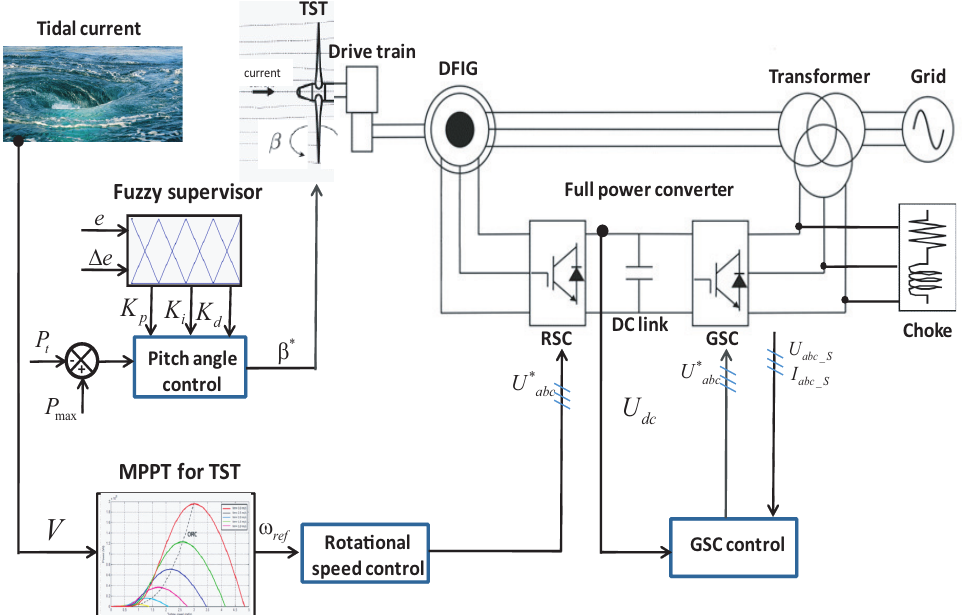
Figure 4. Tidal stream generator control scheme. TST , Doubly Fed Induction Generator (DFIG), Rotor Side Converter (RSC), Grid Side Converter (GSC), Maximum Power Point Tracking (MPPT).